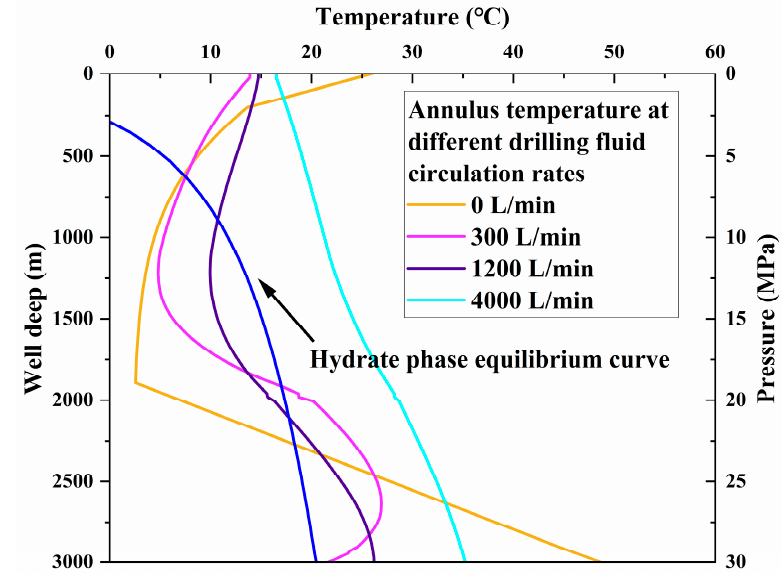
Figure 5. Risk of gas hydrate formation in the case wellbore at different drilling fluid circulation rates.